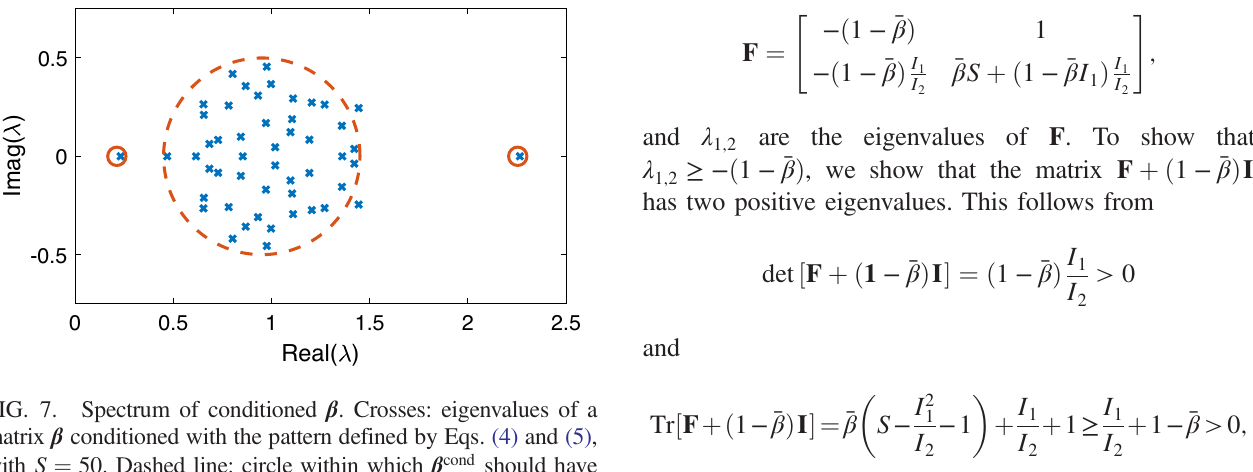
are i.i.d :: 50 ¯ β ¼ 0 . 05 ; σ ¼ 0 . 5